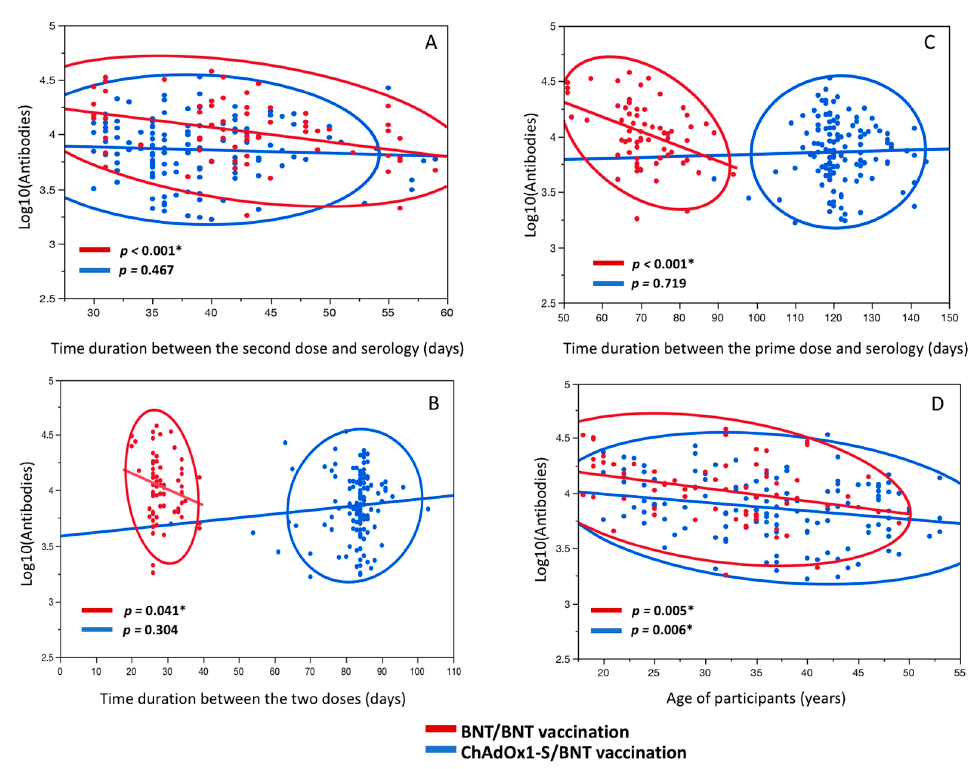
Figure 2. Association between IgG antibody levels and time duration aspects and age. ( A ) Association between IgG antibody levels and time duration between second vaccination and serology test for BNT/BNT and ChAdOx1-S/BNT. ( B ) Association between IgG antibody levels and time duration between prime and second vaccinations for BNT/BNT and ChAdOx1-S/BNT. ( C ) Association between IgG antibody levels and time duration between prime vaccination and serology test for BNT/BNT and ChAdOx1-S/BNT. ( D ) Association between IgG antibody levels and age of healthcare workers for BNT/BNT and ChAdOx1-S/BNT. * Significant models after adjustment for all covariates.